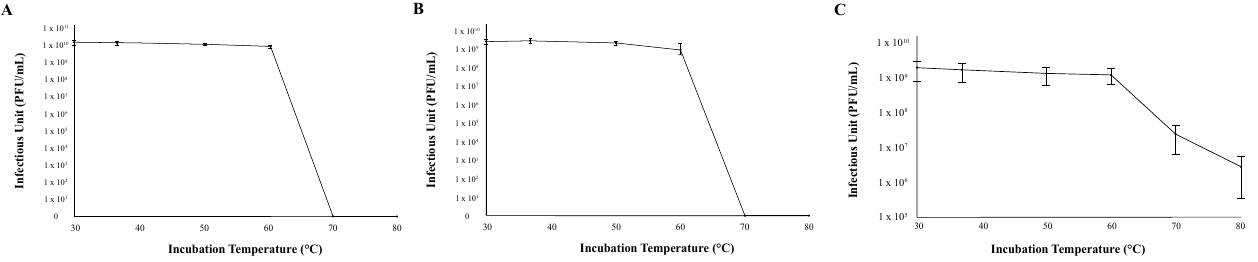
Figure 3. Thermal stability of phages. Error bars depict the standard deviations between the titers generated from three independent assays: ( A ) KaiHaiDragon; ( B ) OneinaGillian; ( C ) YuuY.